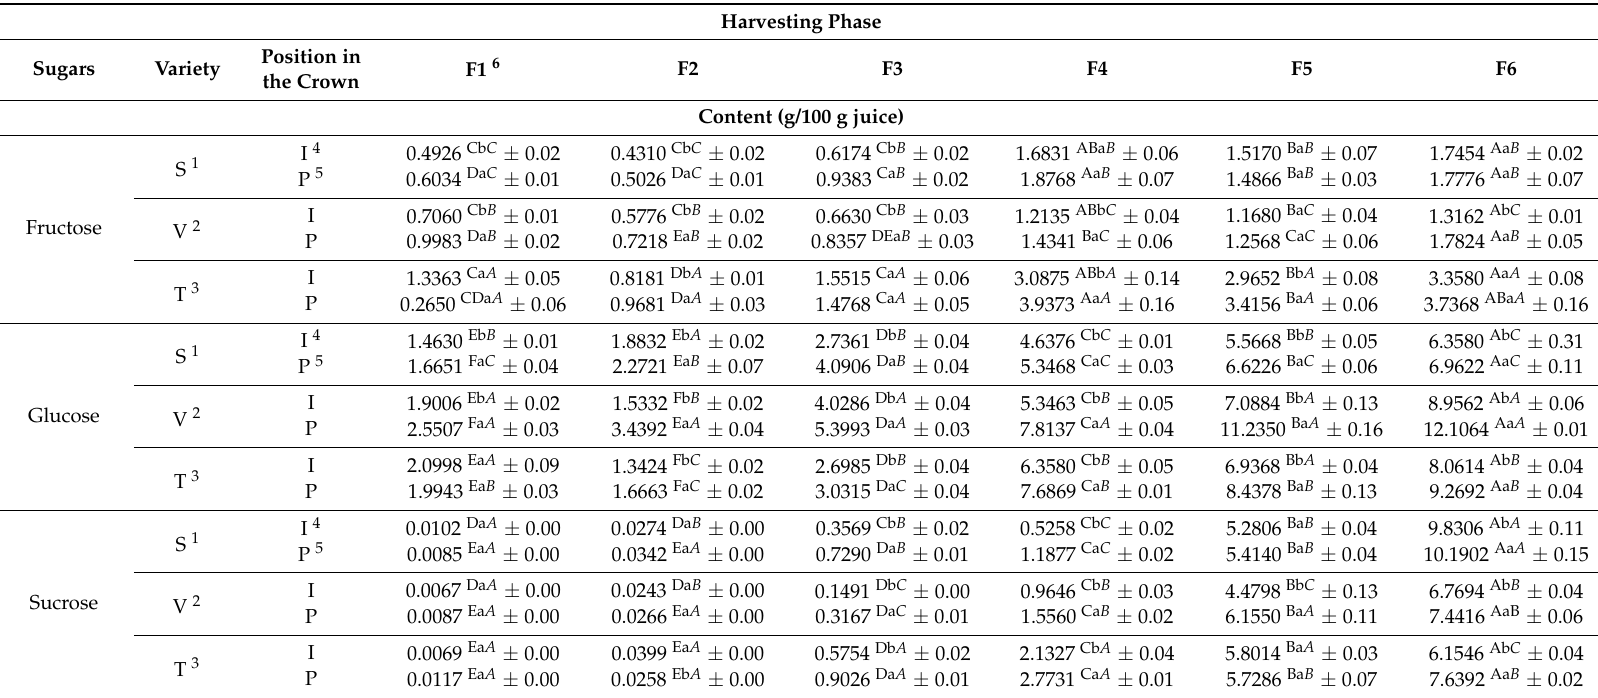
Table 1. Changes in the individual sugar content of three varieties of plum fruit during growth and